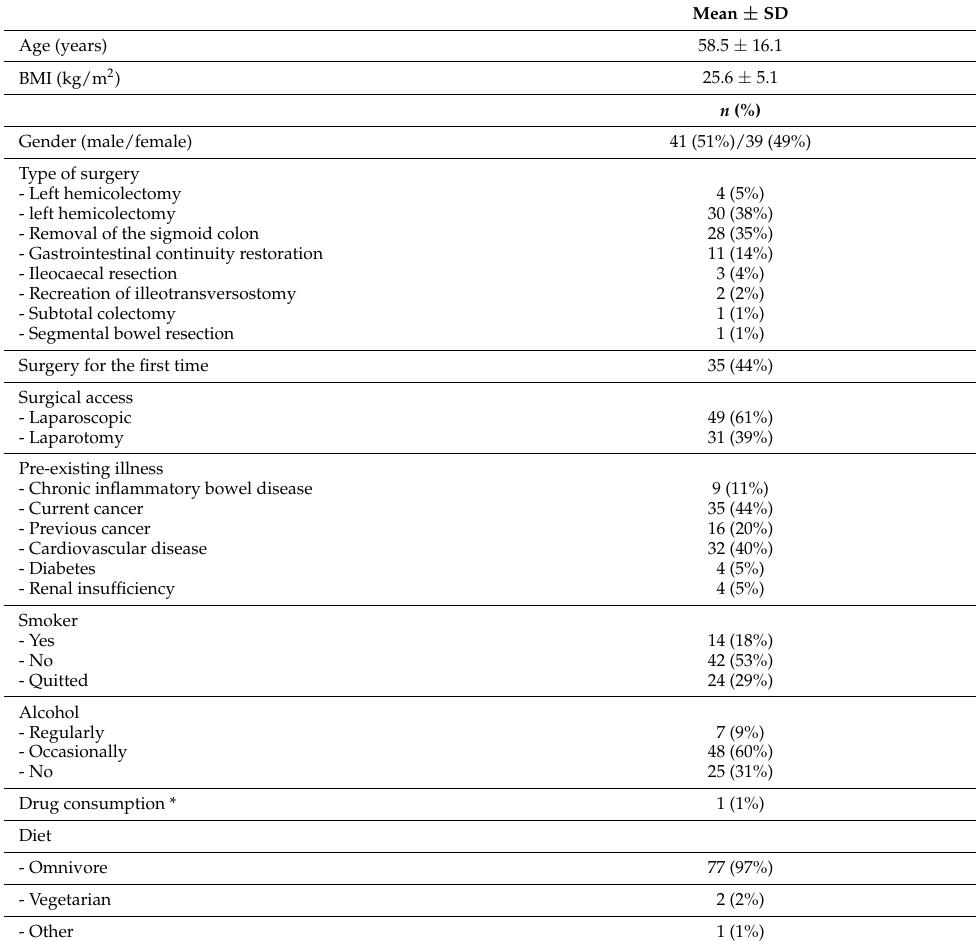
Table 1. Descriptive data of patients completing questionnaire preoperatively and on the 3rd postoperative day ( n = 80).